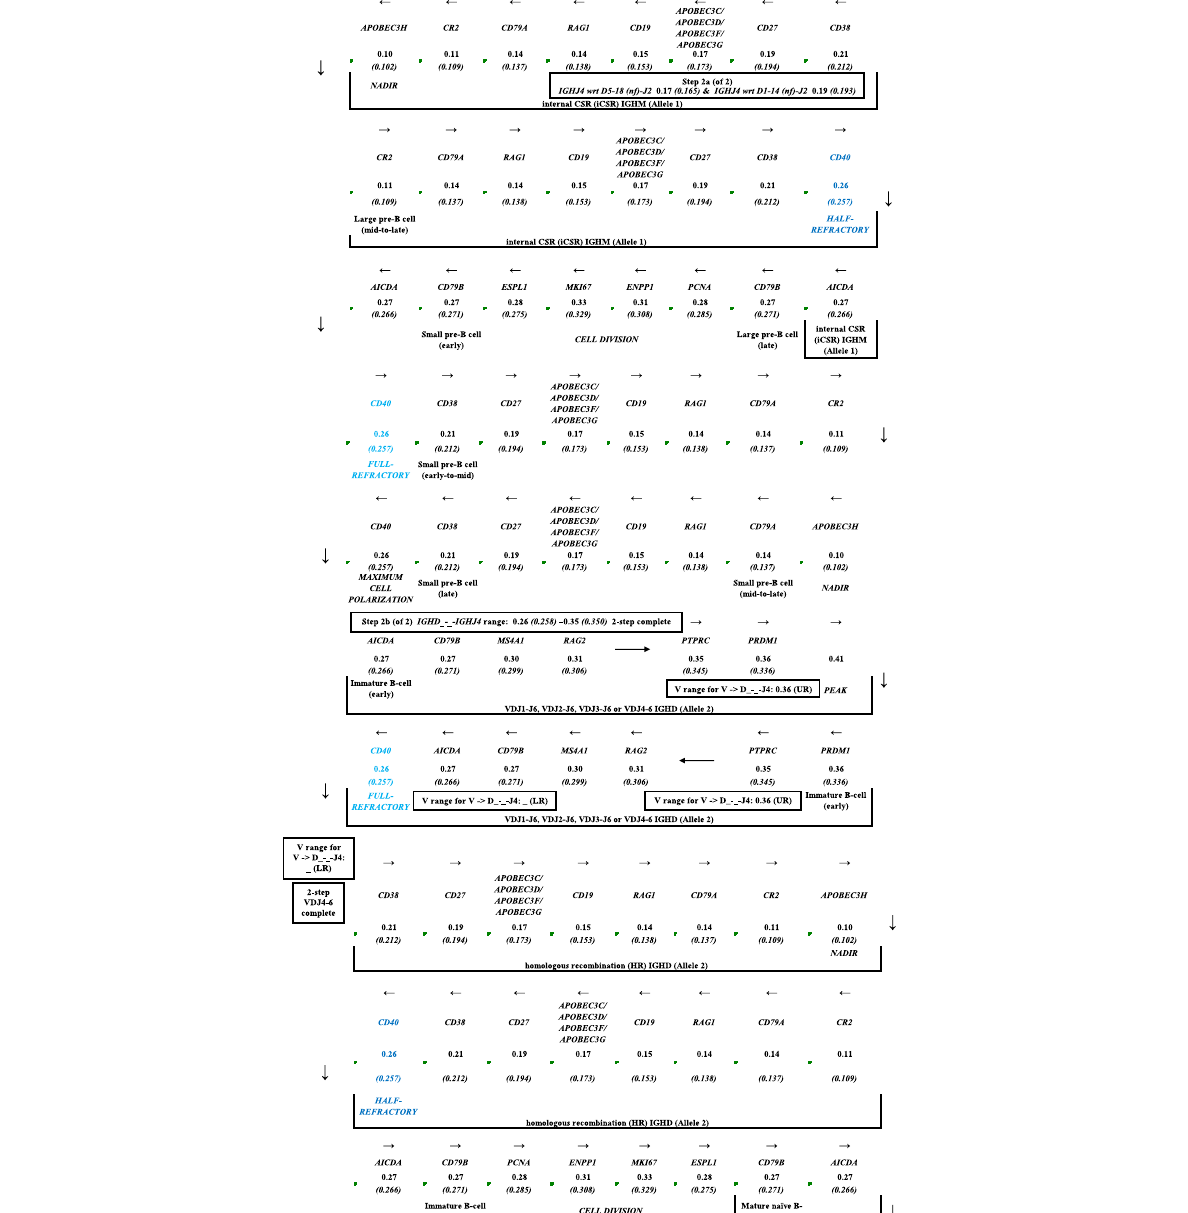
esebssiwaagoT Q units range, 0.41 – 0.36. Black, CD40 at maximum cell polarization potential. Dark blue, CD40 at half-refractory. Light blue, CD40 at full-refractory. Text boxes with complete borders, 2-step. Text boxes with dashed borders, 1-step. Large rectangular box with complete borders, extra-nodal secretory antibody